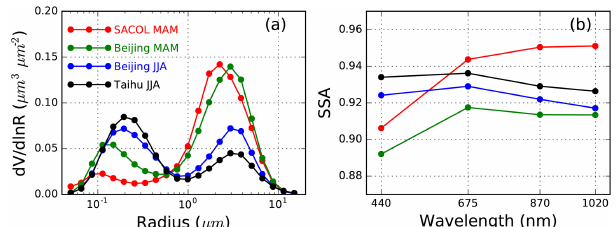
Figure 8. (a) Volume size distribution, (b) spectral single-scattering albedo (SSA) for dust-dominant aerosols (SACOL in spring), an- thropogenic aerosols (Beijing and Taihu in summer) and aerosols of mixed types (spring Beijing) derived from the long-term AERONET observations.